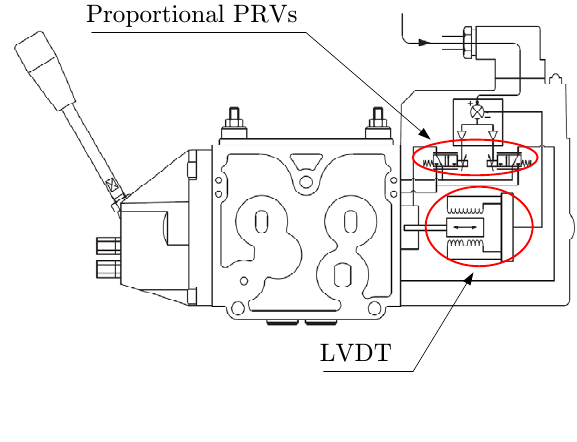
Figure 2: EHA main components.